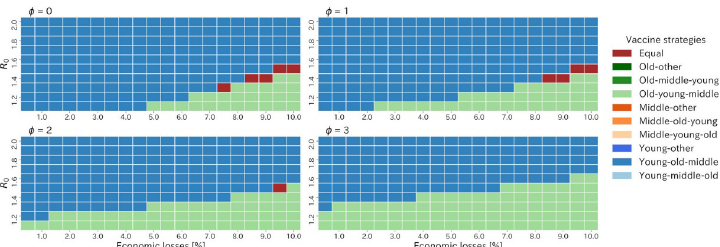
Fig 5. Heatmap of the best strategies in terms of the cumulative number of deaths among all strategies varying ϕ , R0 and acceptable economic losses.